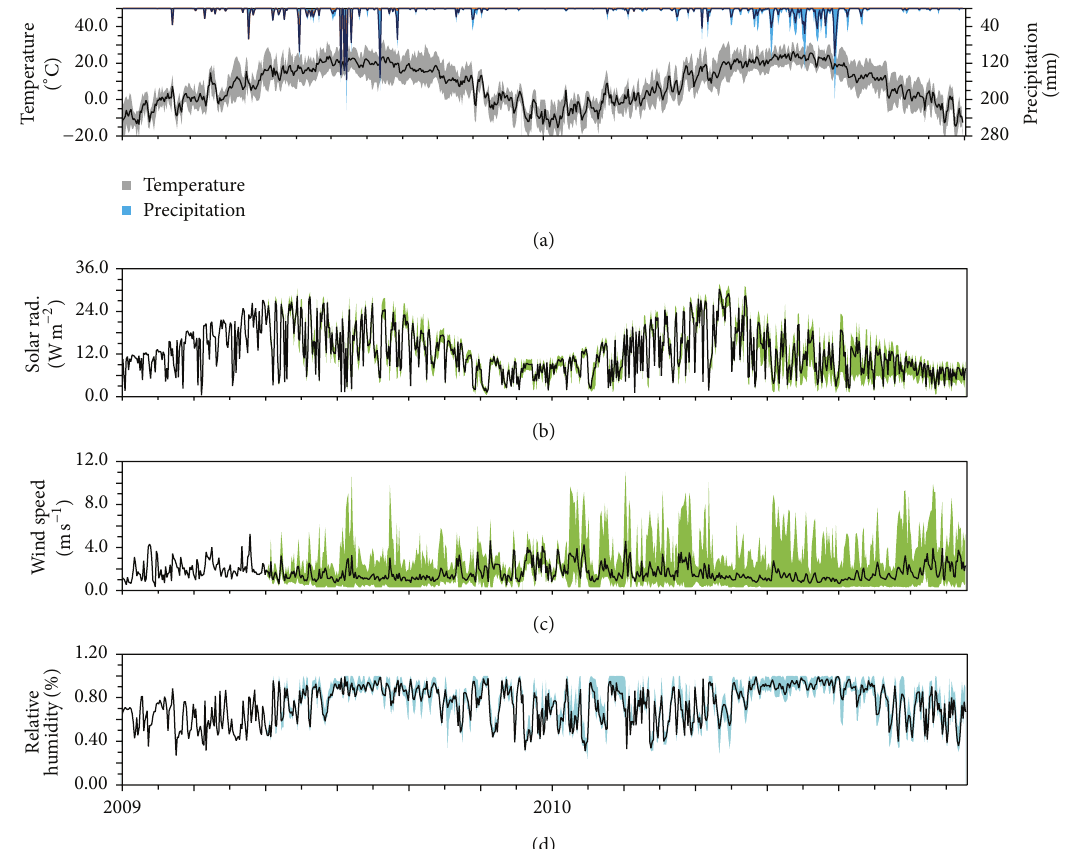
Figure 2: Hourly variability in meteorological parameters ((a) temperature and precipitation, (b) solar radiation, (c) wind speed, and (d) relative humidity) between all of the stations in the Haean study area for 2009 and 2010. The average time series between all locations for each of the parameters is also provided.